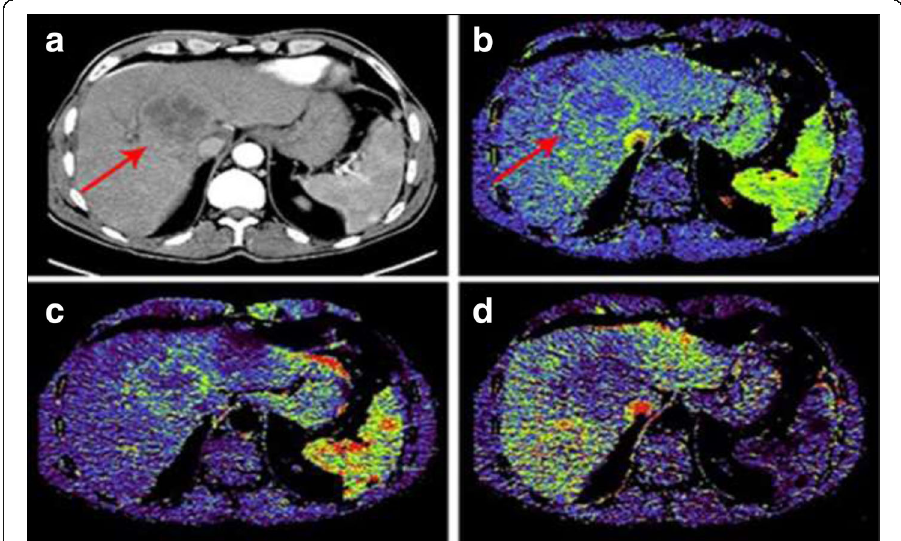
Fig. 3 CT-perfusion in moderately differentiated hepatocellular carcinoma. Patient P. Moderately